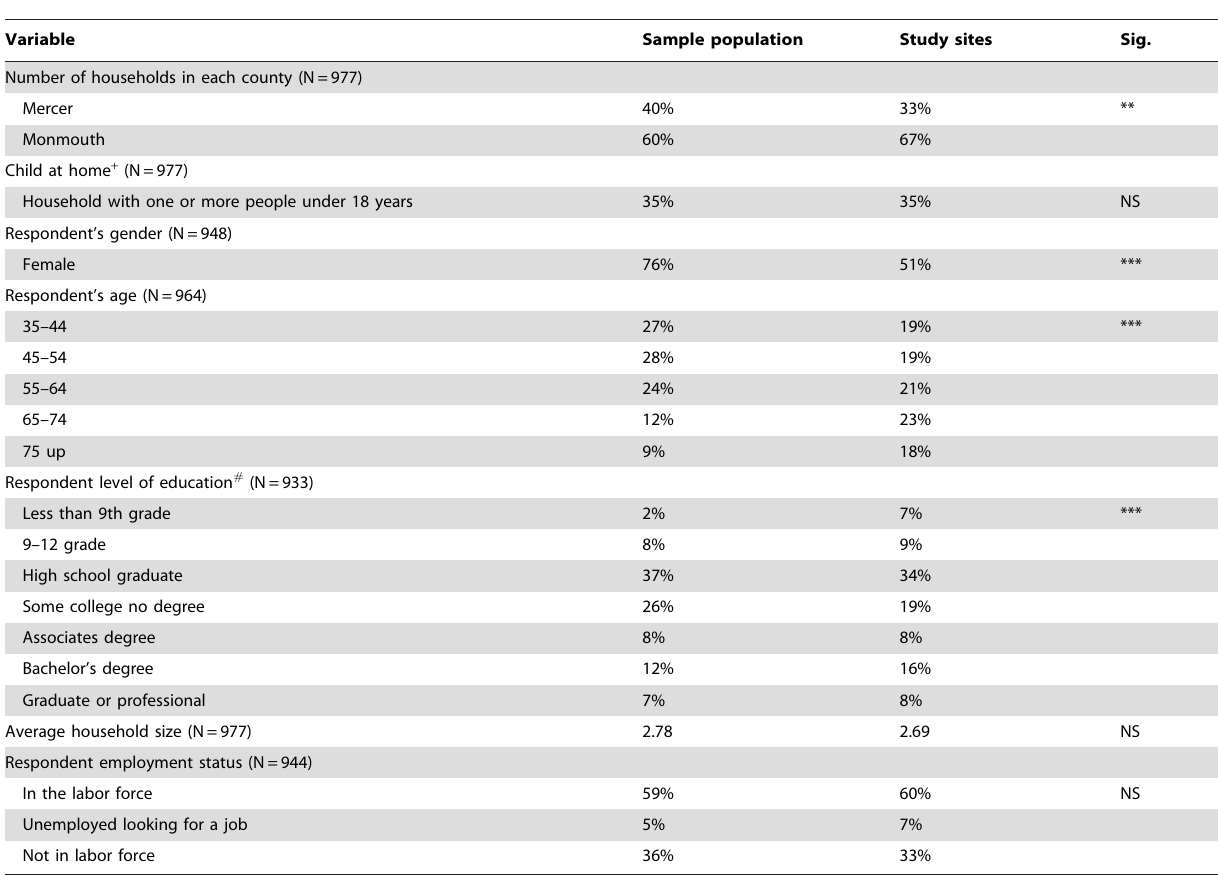
Table 1. Household characteristics of respondents compared to study sites {